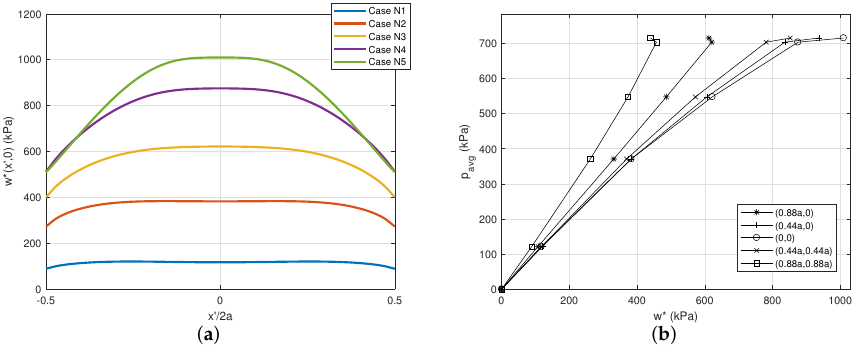
Figure 8. Results for normalized vertical surface displacement w ∗ under five normal compressive traction loading cases N1–N5. ( a ) Cross-sectional displacement across the center of the loaded region ( y (cid:48) = 0). ( b ) Average pressure vs. normalized displacement for five points within the loaded domain.